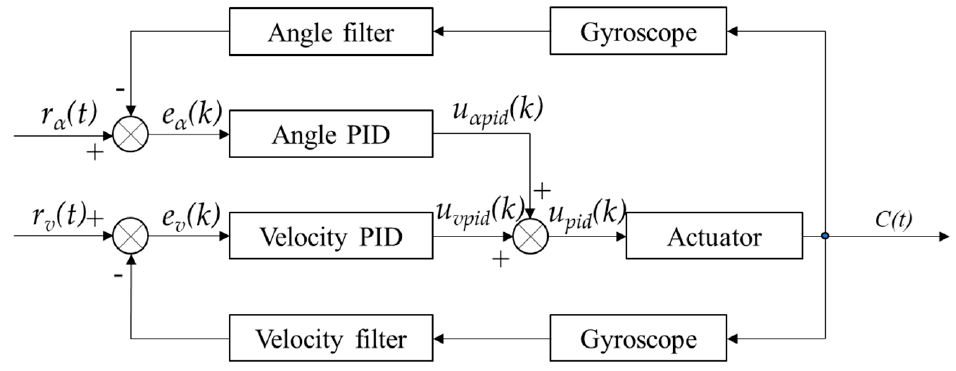
Figure 7. PID control strategy for the leveling function, speed tracking, and position compensation Figure 7. algorithm.